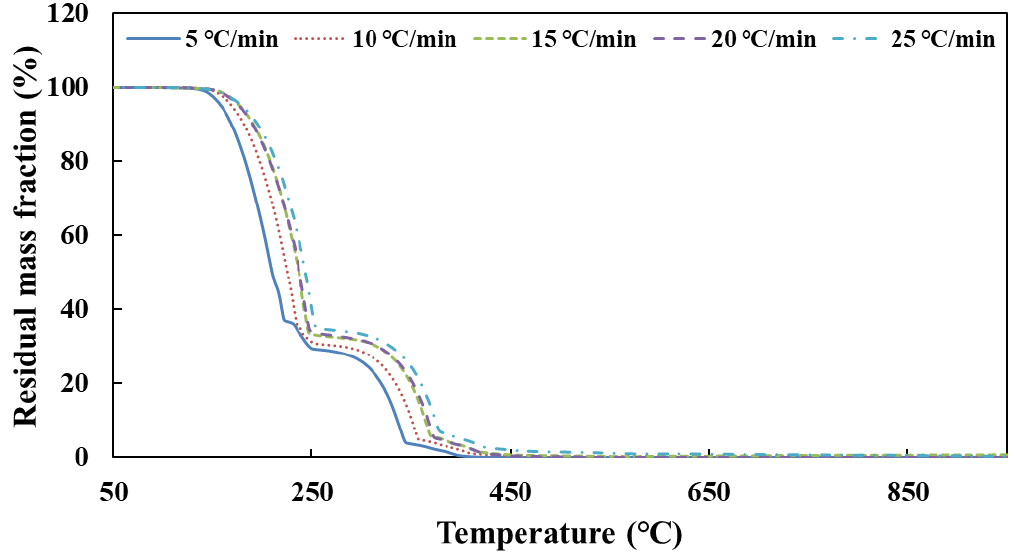
Figure 2. The TG curves of urea pyrolysis at different heating rates. According to the TG curves of urea pyrolysis, the temperature data corresponding to each conversion rate are obtained at different heating rates. Table 1 shows the result of the activation energy of urea decomposition by substituting these data into Equation (24). E 12 is the result from two sets of data with heating rates of 5 and 10 ◦ C/min, E 23 , E 34 and E 45 to